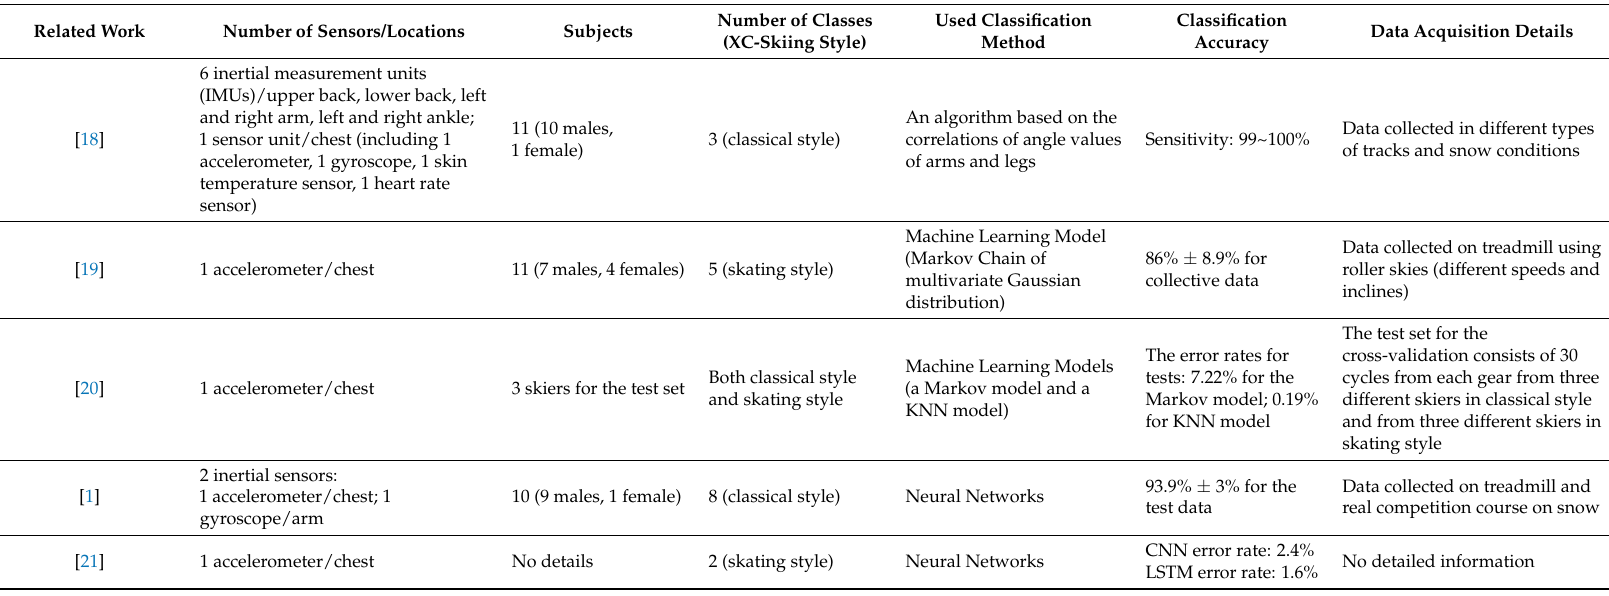
Table 1. Previous studies on XC-skiing technique classification with wearable